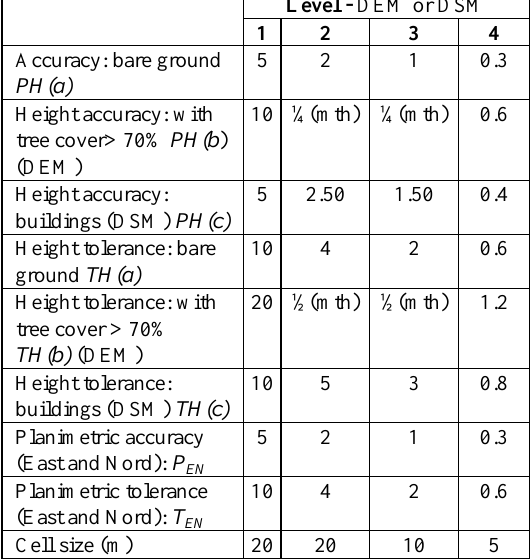
Table 1. Last version of the CISIS (2011) document – ―Large scale orthoimagery and elevation models – Guidelines" shows